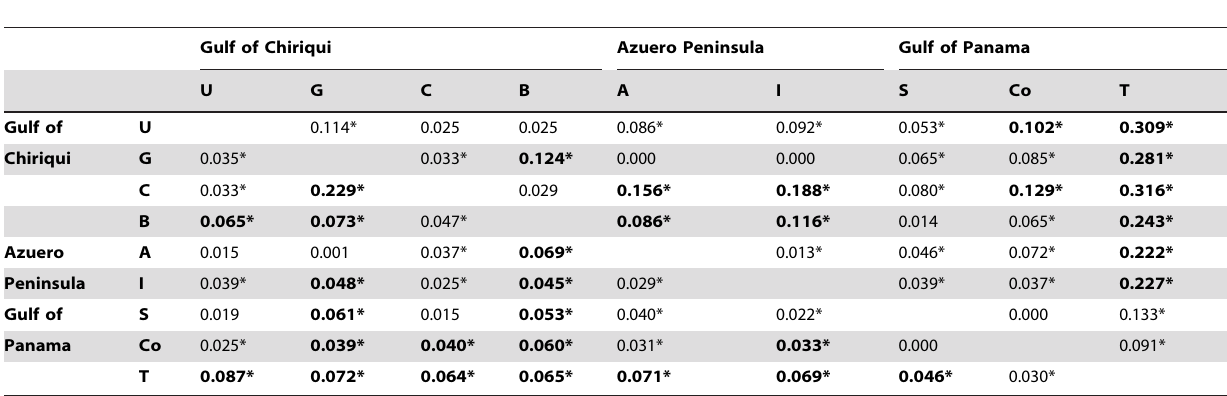
Table 4. Pairwise R ST (above diagonal) and F ST (below diagonal) between TEP P. damicornis populations.